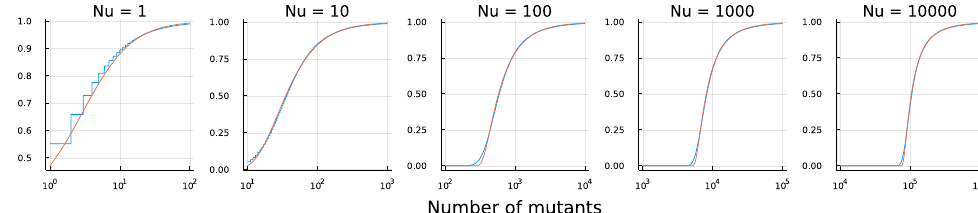
Figure 3. Cumulative probability distribution for the number of neutral mutants. Each population starts with one cell and grows to N cells. Mutations occur at rate u . The blue curves show the Luria–Delbrück distribution calculated by the simu.cultures computer simulation of the R package rSalvador [13]. The orange curves show the Fréchet distribution in Equation (3). Reprinted from from Figure 1 of Frank [14]. See that article for further details. The mathematical reason for the close match between the Luria–Delbrück distribution and the Fréchet distribution arises by linking two separate studies. Kessler and Levine [15] showed that the Luria–Delbrück distribution converges to a Lévy α -stable distribution for large Nu . Separately, Simon [16] showed the close match between the Lévy α -stable distribution and the Fréchet distribution. Using the Fréchet distribution provides a benefit because no explicit mathematical expression exists for the Lévy α -stable probability